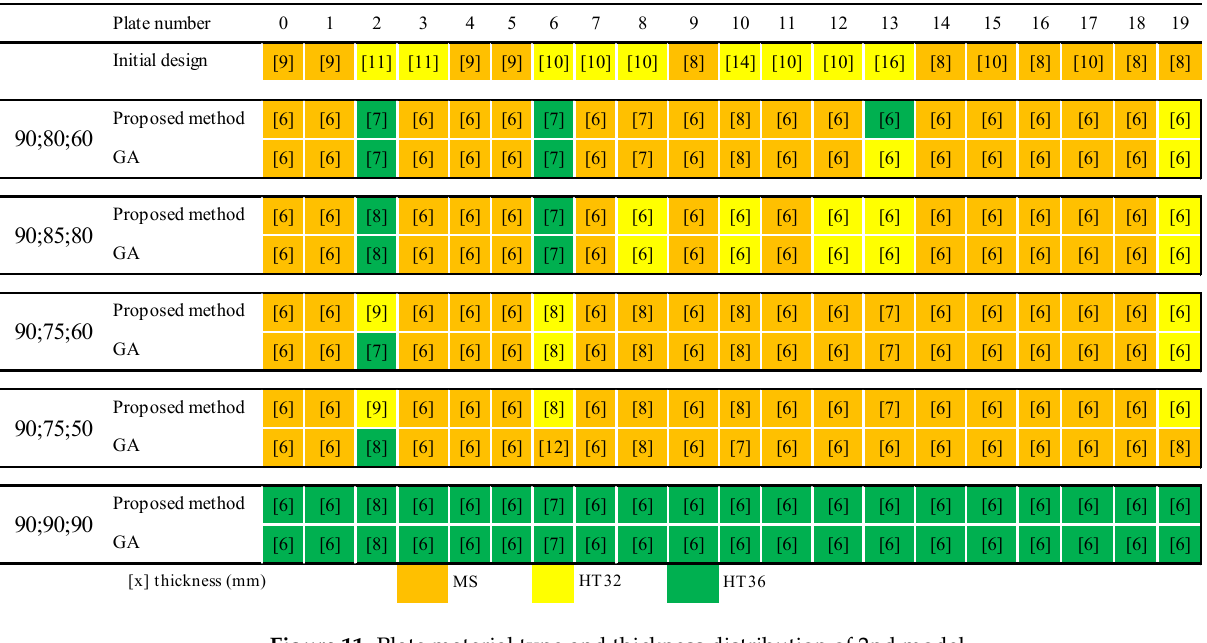
Figure 11. Plate material type and thickness distribution of 2nd model.